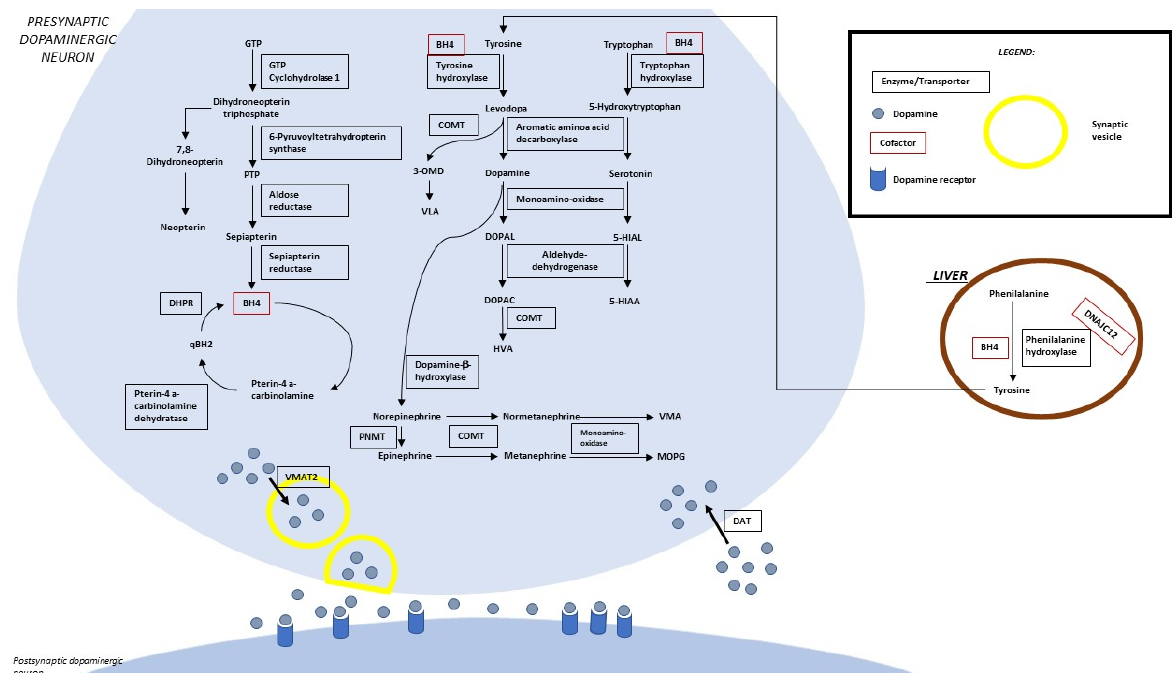
Figure 1. Biogenic amine and pterin metabolism. LEGEND: 5 ‐ HIAA, 5 ‐ hydroxyindoleacetic acid; 5 ‐ HIAL, 5 ‐ hydroxyindoleacetaldehyde; BH4, tetrahydrobiopterin; DHPR, dihydropterine reductase; DOPAC, 3,4 ‐ dihydroxyphenylacetic acid; DOPAL, 3,4 ‐ dihydroxyphenylacetaldehyde; DAT, dopamine transporter; GTP, guanosine ‐ 5 ′‐ triphosphate; HVA, homovanillic acid; MOPG, methoxylhydroxyphenylglycol; PLP, pyridoxal 5 ′‐ phosphate; PNMT, phenylethanolamine N ‐ methyltransferase; PTP, 6 ‐ pyruvoyltetrahydropterin; qBH2, quinonoid dihydrobiopterin; VLA, vanillyllactic acid; VMA, vanillylmandelic acid; VMAT 2, vesicular monoamine transporter.